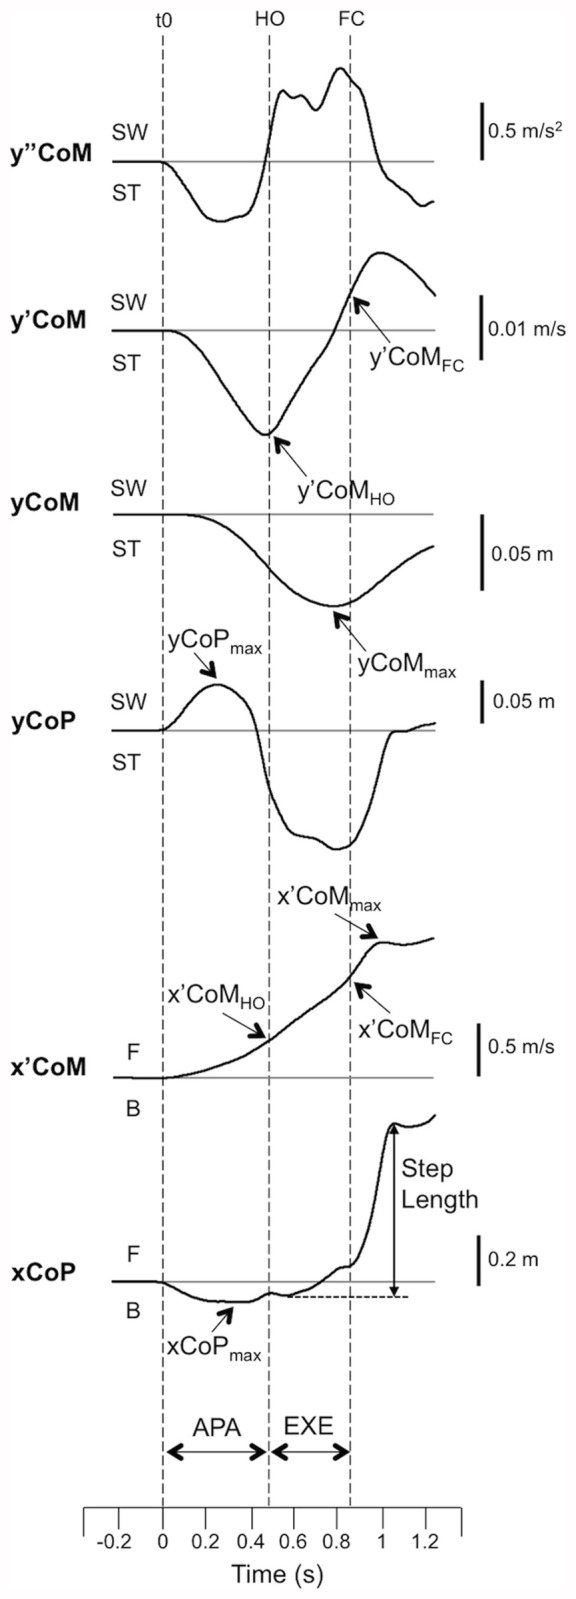
Example of the main biomechanical traces obtained for one subject during gait initiation gait (one trial) under the Symmetrical condition. y”CoM, y’CoM, yCOM, yCoP: mediolateral center-of-mass (CoM) acceleration, velocity and displacement, mediolateral center-of-pressure (CoP) displacement, respectively. x’COM, xCoP: anteroposterior CoM velocity and anteroposterior CoP displacement, respectively. T0 indicates the onset variation of the y”CoM trace from the baseline. HO and FC: swing heel-off and swing foot-contact, respectively. F and B indicate forward and backward movement, respectively. ST and SW indicate stance limb and swing limb, respectively. x’CoMHO, x’CoMFC, x’CoMmax, xCoPmax: anteroposterior CoM velocity at heel-off, at foot-contact, at the end of the first step and maximal backwards CoP shift, respectively. y’CoMHO, y’CoMFC, yCoMmax, yCoPmax: mediolateral CoM velocities at heel-off, at foot-contact, maximal mediolateral CoM displacement towards the stance leg and maximal mediolateral CoP displacement towards the swing leg during anticipatory postural adjustments (APA). APA and EXE: time windows for APA and step execution.